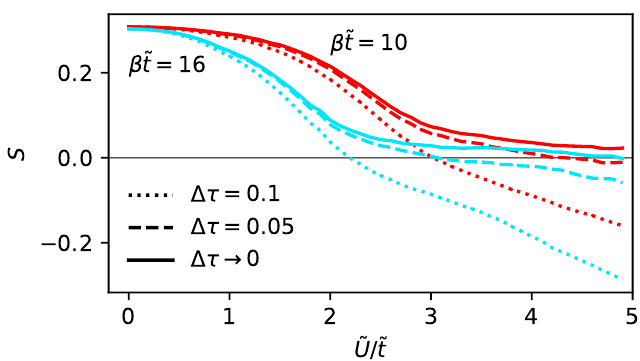
Figure 7: (Color online) Entropy from DQMC simulations with ∆ τ = 0.1 (dotted lines), ∆ τ = 0.05 (dashed lines) and from extrapolated observables for β ˜ t = 10 (red) and β ˜ t = 16 (blue). The linear size of the simulated square lattice is L = 8. Trotter discretizations of ∆ τ = 0.2, 0.1, and 0.05 and linear lattice sizes of L = 8, 10, and